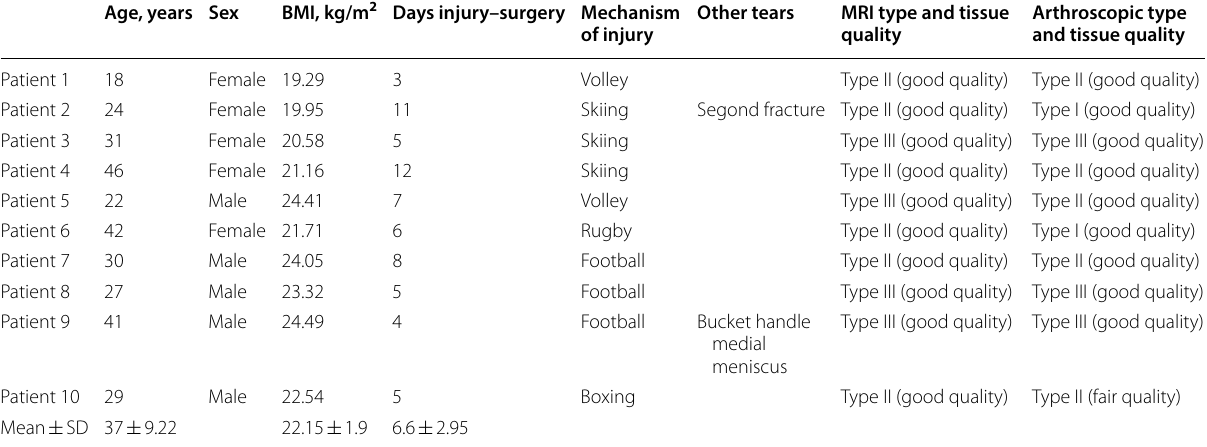
SD standard deviation, BMI body mass